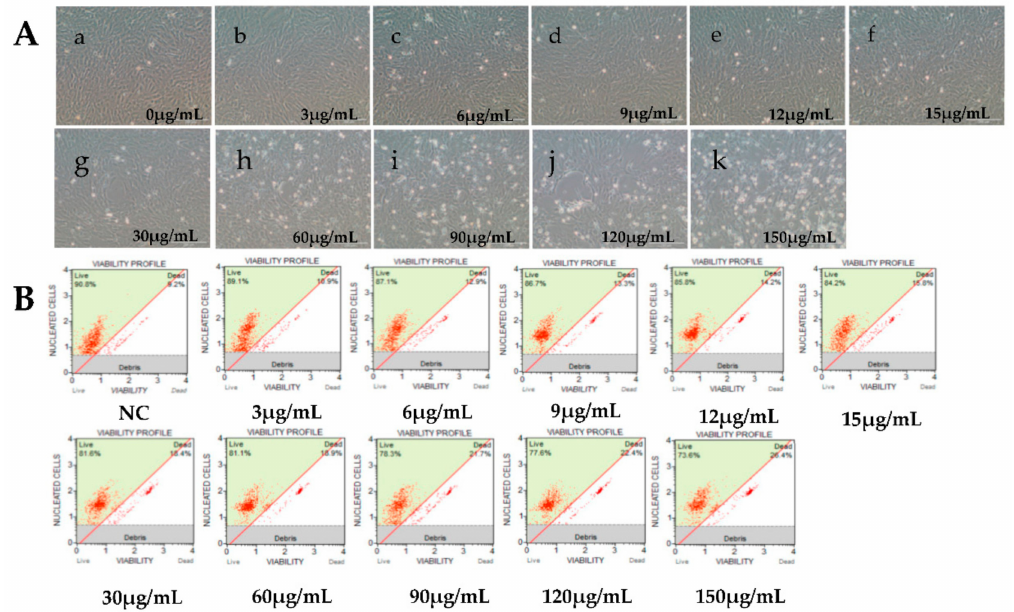
Figure 1. E ff ects of cycloheximide (CHX) at di ff erent concentrations on RyuF-2 cell viability. Cells were treated with CHX to inhibit protein synthesis in order to screen for immediately genes. Cell viability was determined under a microscope after 14 h of treatment with the di ff erent concentrations of CHX (5~150 µ g / mL). ( A , a–k), images of cell cultures under various CHX concentrations. ( B ) Corresponding cell viability graphs.